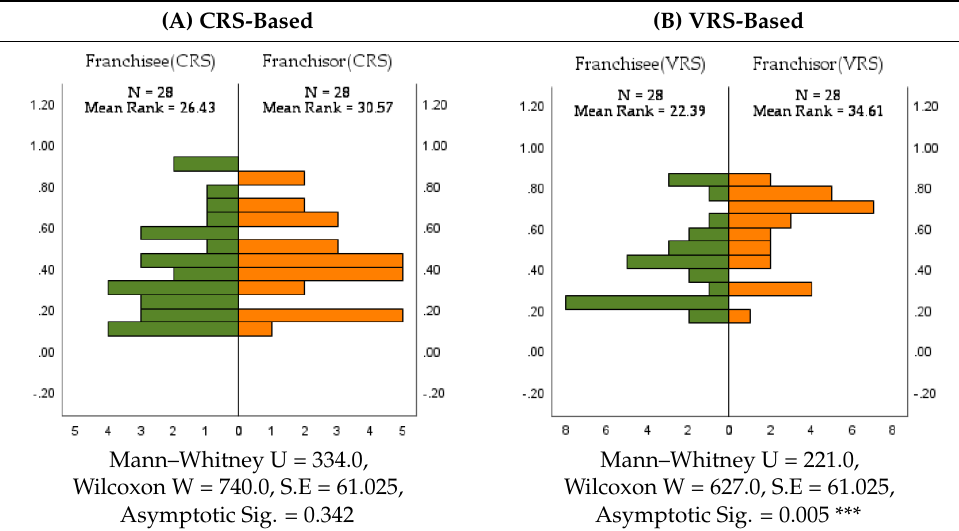
Table 6. Analysis result of Mann – Whitney difference between franchisors and franchisees.